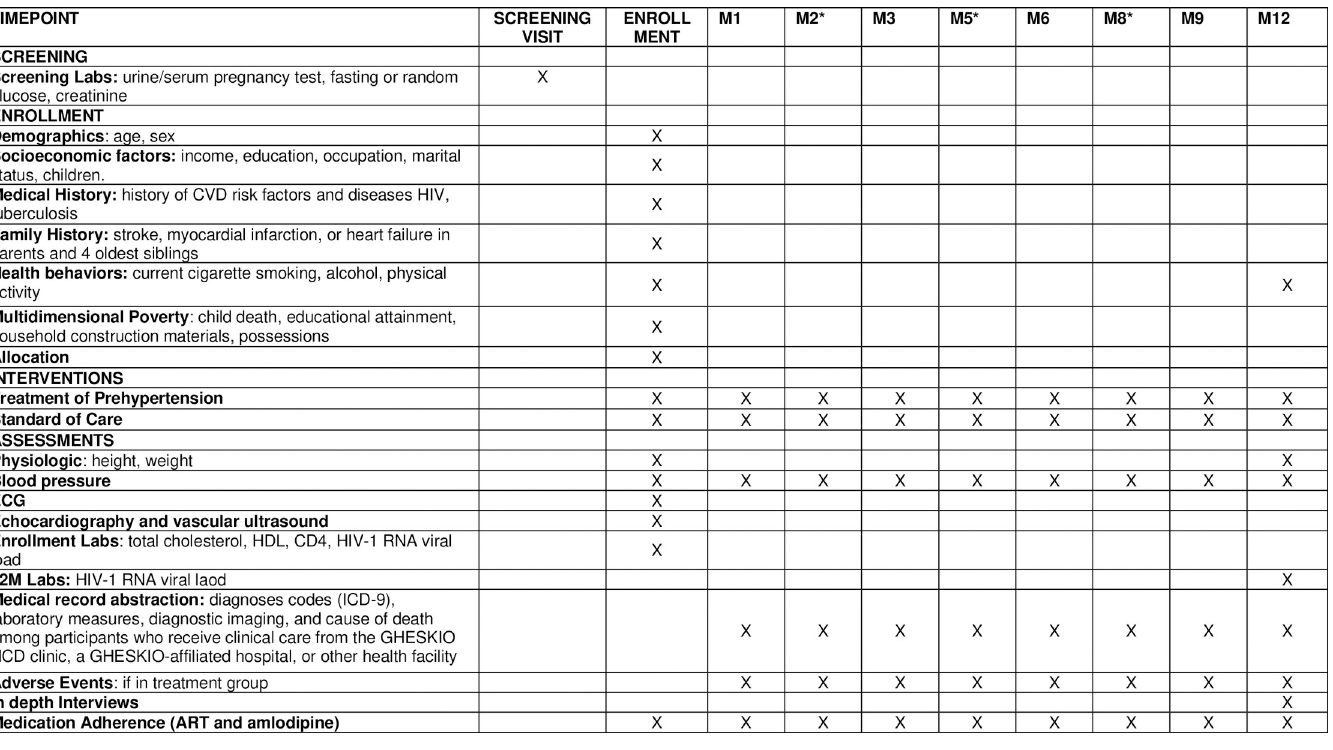
Fig 1. Study measures and schedule. � indicates a study visit in the